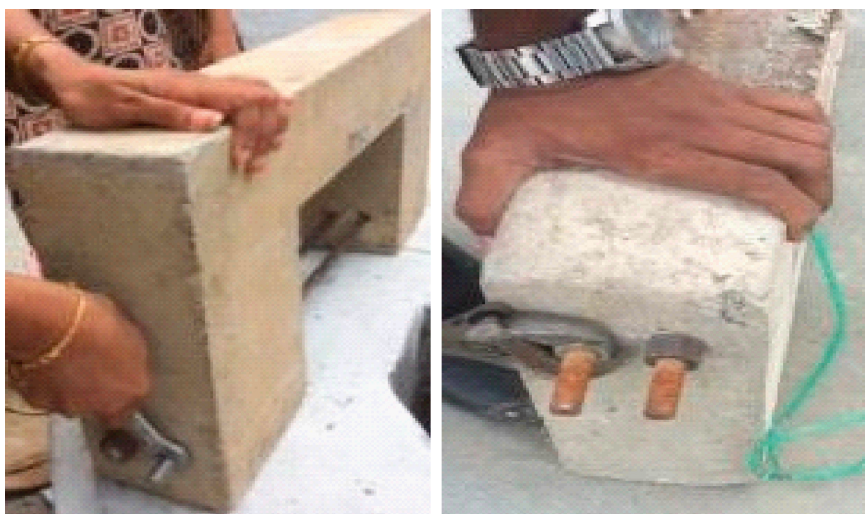
Figure 1: Formation of cracks due to stressing.